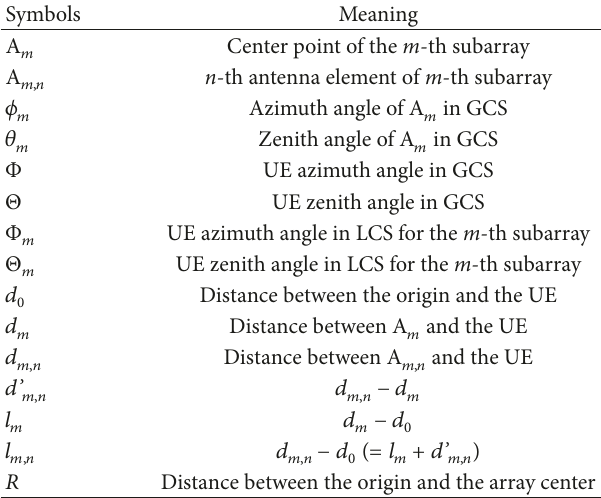
Table 1: Location and beam path